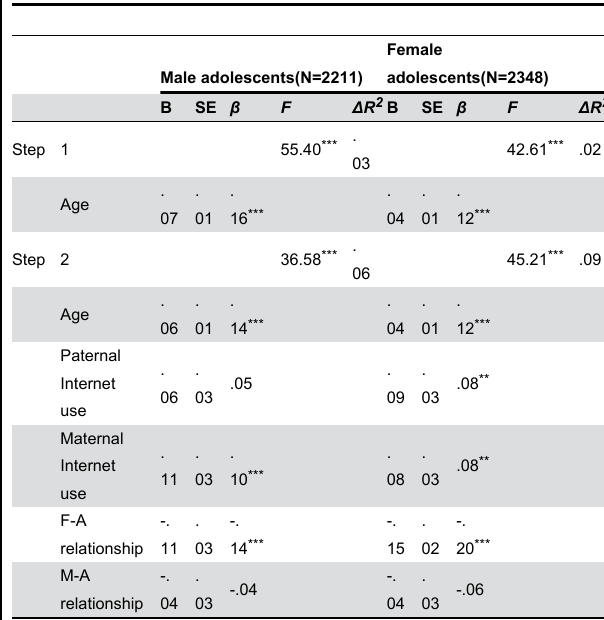
Table 4. Summary of Hierarchical Multiple Regressions for Perceived Parental Internet Use, Parent-adolescent Relationship and